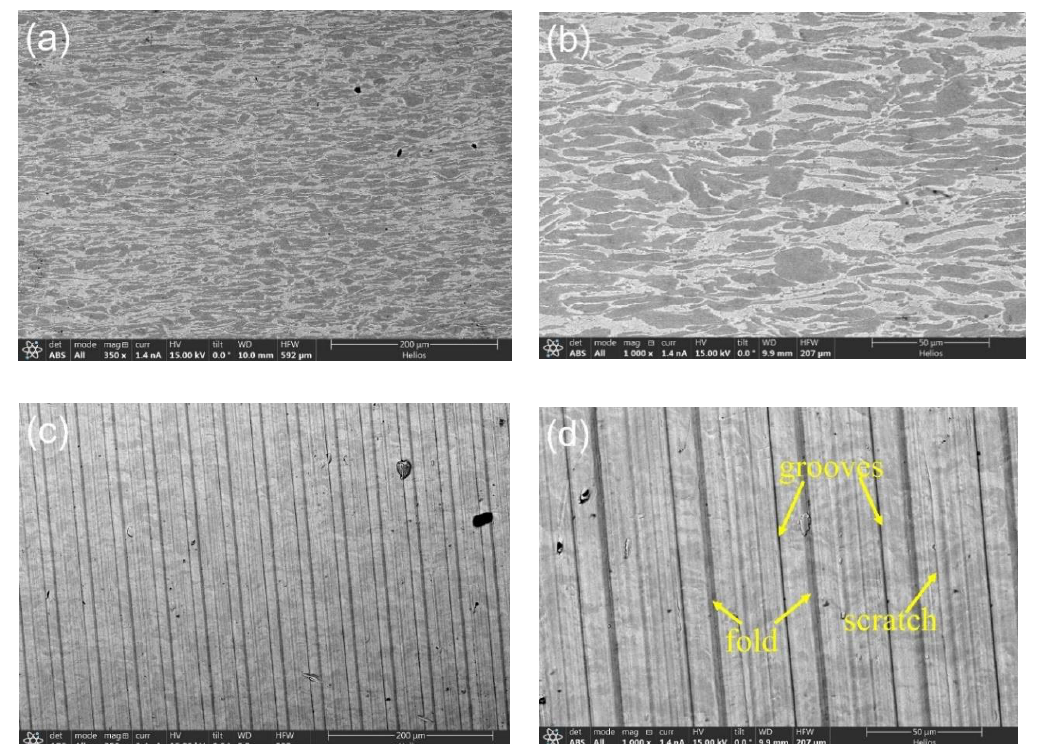
Figure 4. SEM surface morphology observations of ( a , b ) electropolished and ( c , d ) turned